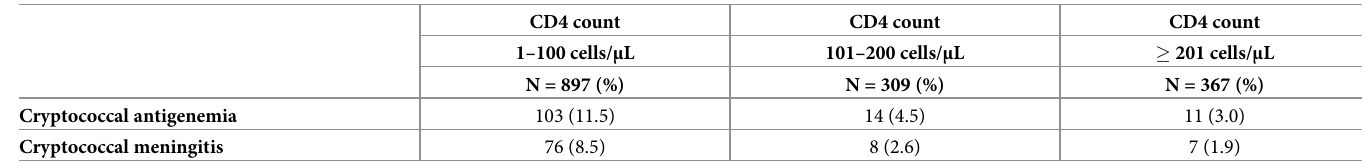
Table 2. Prevalence of cryptococcal antigenemia and cryptococcal meningitis stratified by CD4 count 1